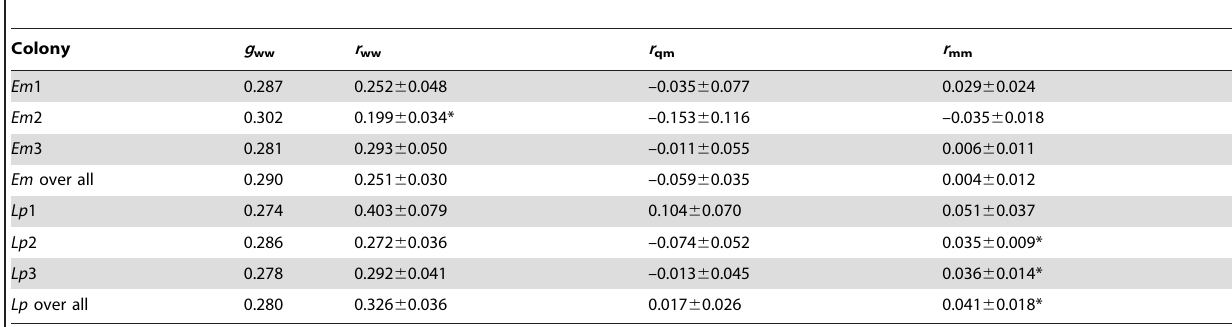
Table 2. Relatedness estimates for three colonies of E. mexicanum and L. praedator from Chiapas, Mexico.